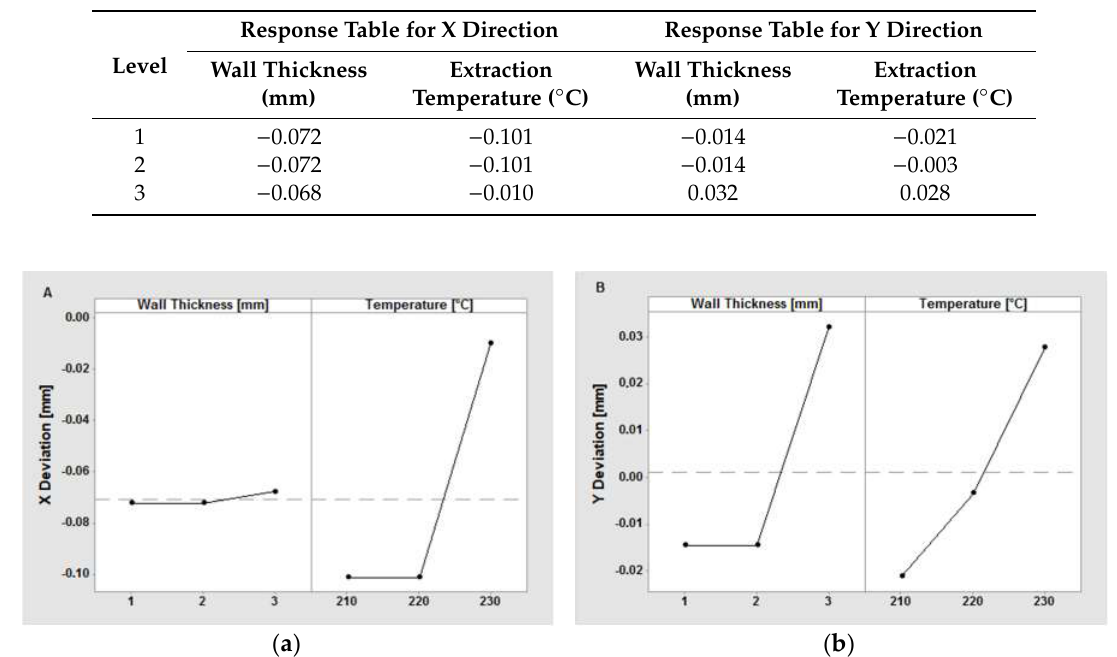
Figure 4. Plot of means for dimensional deviation for ( a ) the X dimension and ( b ) the Y dimension.